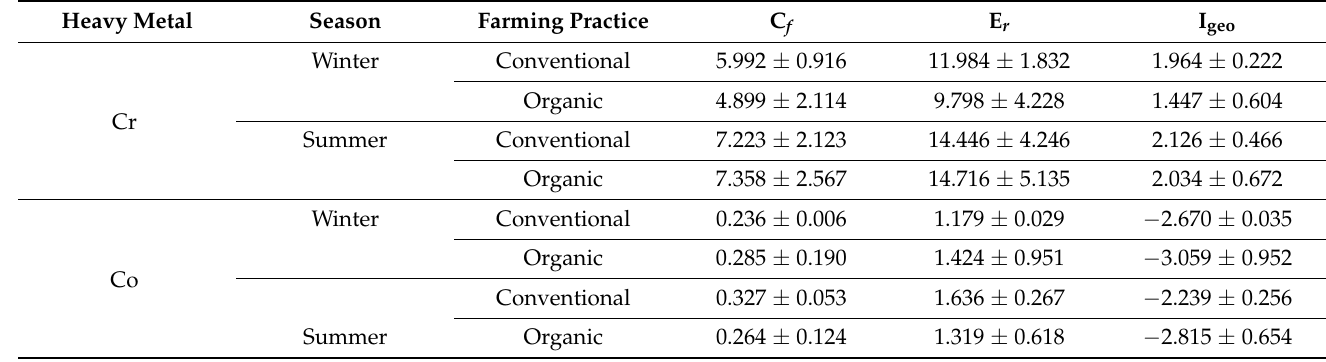
Figure 3. Influence of agricultural practices on heavy metal deposits in soils during the winter ( A ) and summer ( B ) in vineyards in the Cape Winelands. Table 4. Contamination factor (C f ), ecological risk index (E r ), and geo-accumulation Index (I geo ) (Mean ± SE) of heavy metals occurring in the soils of the vineyards and the calculated background levels in soils in the Cape Winelands.